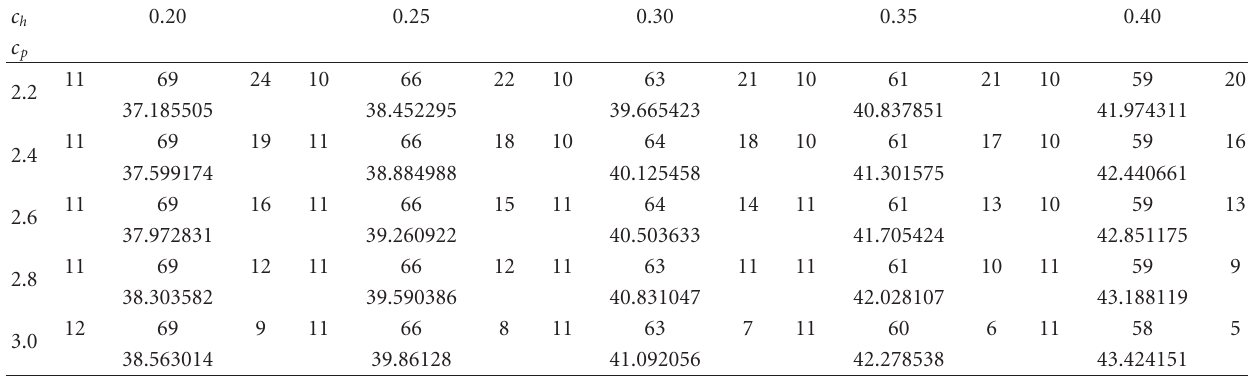
Table 11: Variation in optimal values for di ff erent values of c h and c p ( c s = 15, c sh = 5, c pr = 0 . 3).